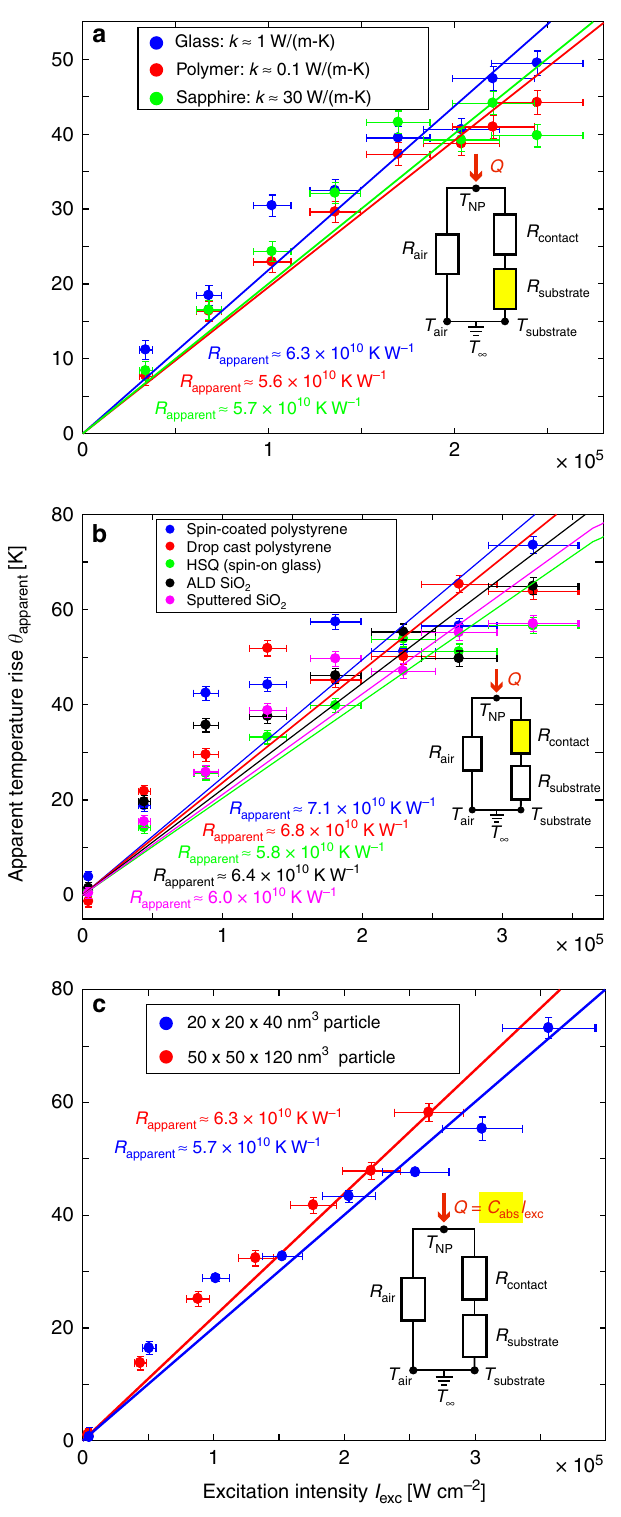
phase precursors.